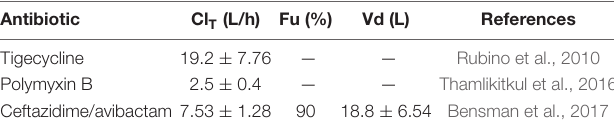
TABLE 2 | Pharmacokinetic parameters (means ± SDs) used in the Monte Carlo simulations. Antibiotic Cl T (L/h) Fu (%) Vd (L)